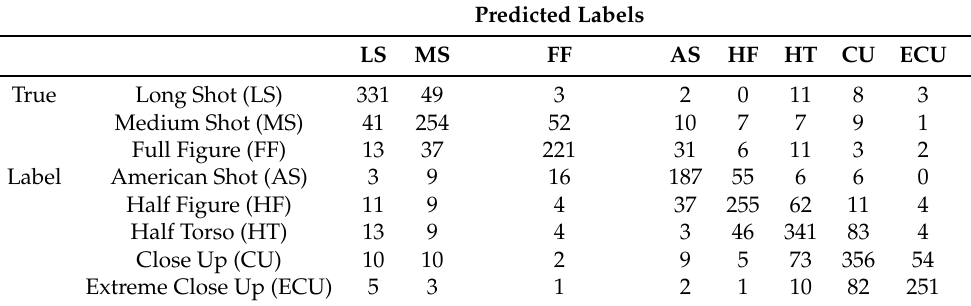
Table 3. Confusion Matrix of the VGG-16 trained on Stylized Dataset.